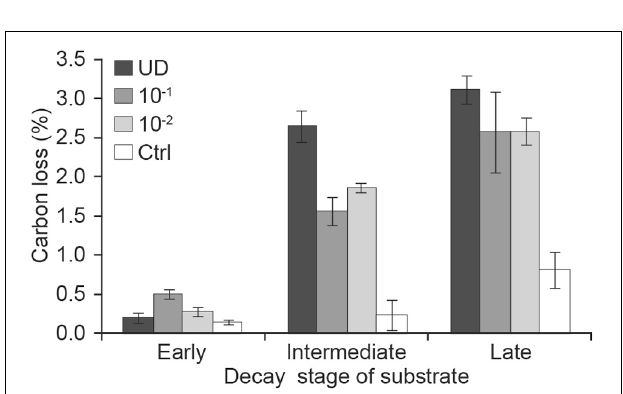
substrate (circles), dilution 10 − 2 g inoculum/g substrate (triangles), and controls (diamonds). Error bars indicate the SD of the mean for observations and were calculated for each decay stage and dilution separately.